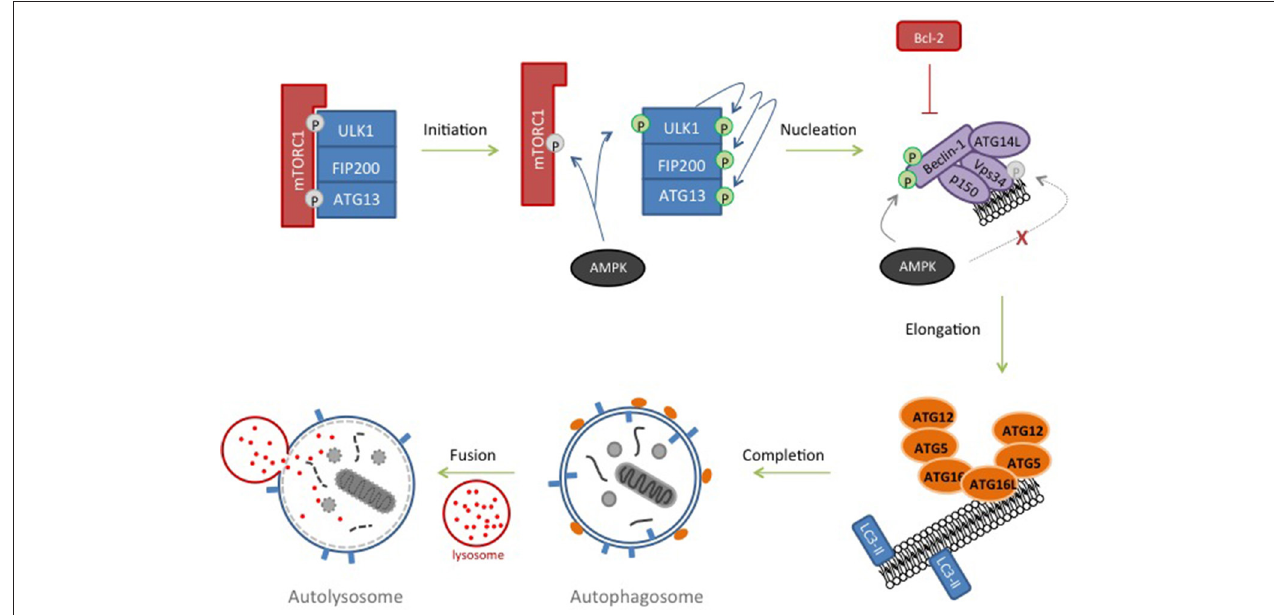
FIGURE 3 | Autophagy. In response to nutrient deprivation, inhibition of ULK1-FIP200-ATG13 complex by mTORC1 is removed. ULK1 autophosphorylates and activates ATG13 and FIP200. AMPK, activated in response to starvation, contributes by phosphorylating and inhibiting components of the mTORC1 complex and phosphorylating and further activating ULK1. ULK1 subsequently phosphorylates Beclin-1 and Vps34 resulting in nucleation of the isolation membrane. Inhibitory phosphorylation of Vsp34 by AMPK is prevented by recruiting ATG14L to the complex and AMPK then phosphorylates and further activates Beclin-1. Lipids are recruited to the growing phagophore and two ubiquitin-like conjugation pathways are triggered resulting in an ATG12-ATG5-ATG16 complex at the autophagosome and LC3-II insertion into the membrane, where it recruits cargo. Lysosomes dock to the outer membrane of the autophagosome forming an autolysosome, and allowing hydrolases to degrade its